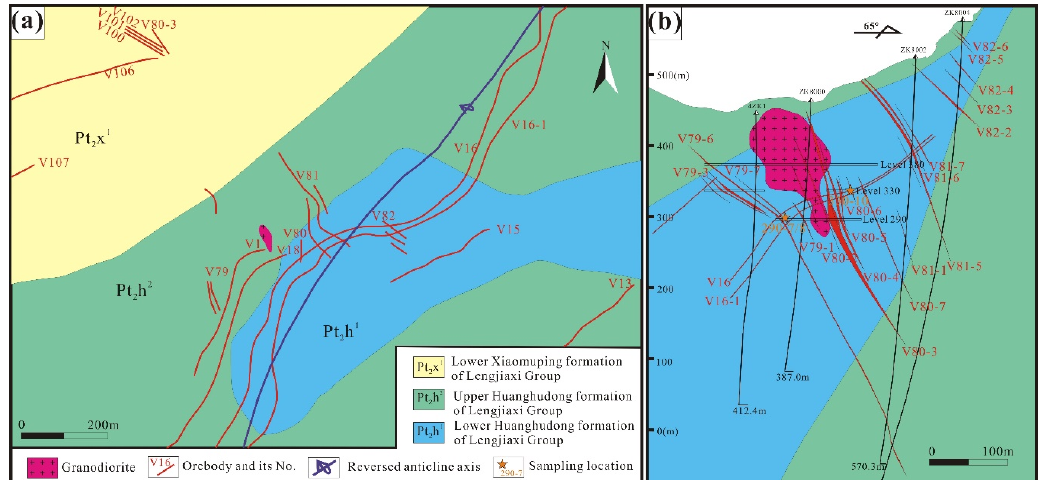
Figure 2. ( a ) Geological map of the Zhengchong gold deposit; ( b ) cross-section showing geological features of the ore and the host rocks of the deposit, including sampling location.